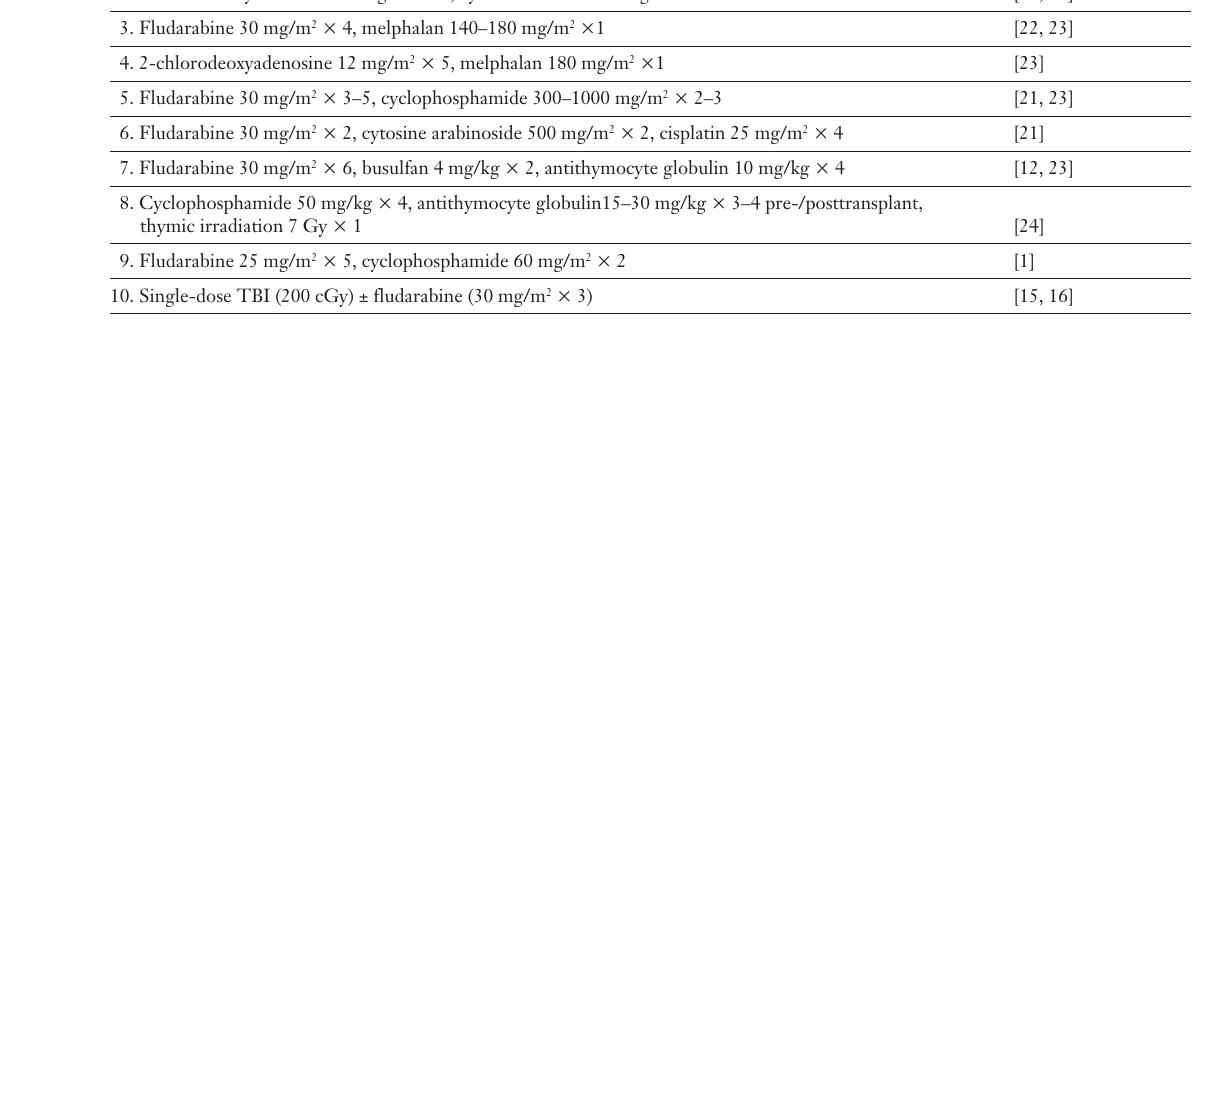
Reduced intensity conditioning